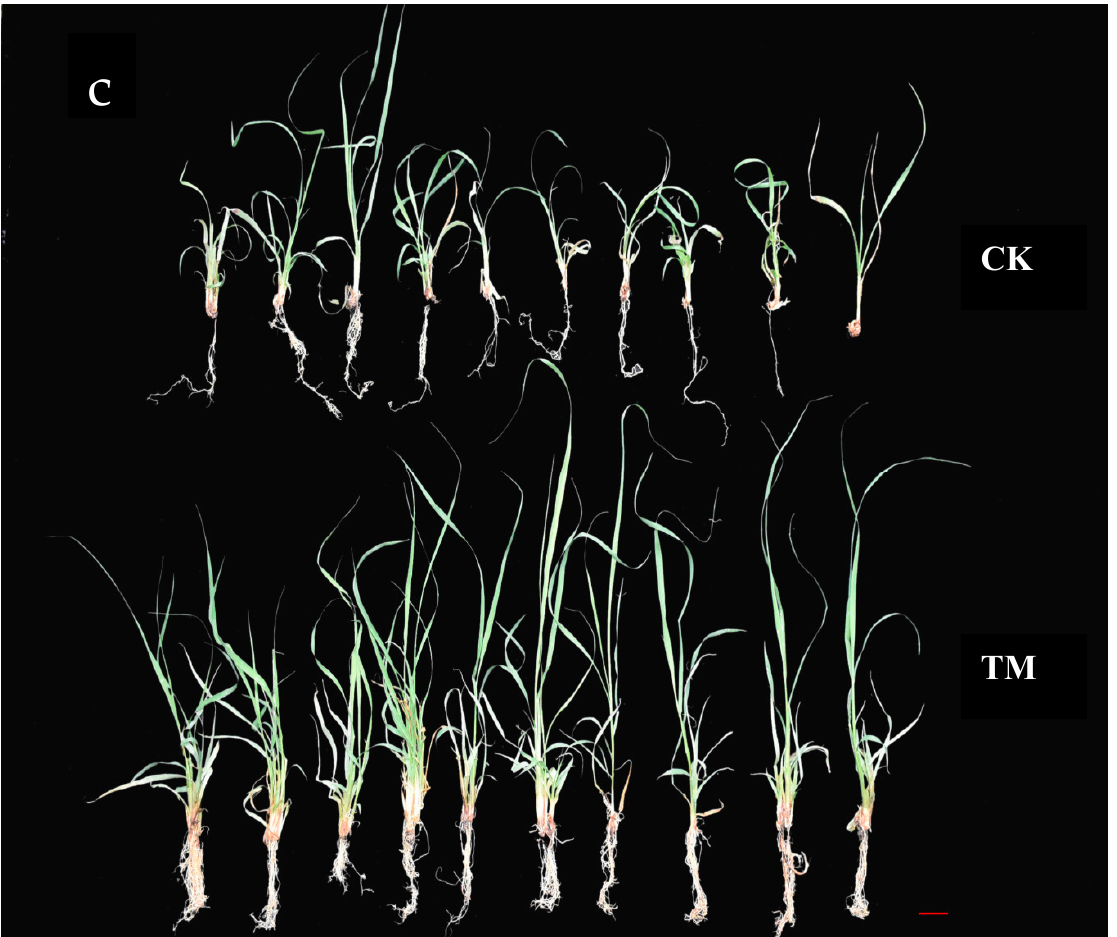
Figure 1. Effects of the indole-3-butyric acid (IBA) and 1-naphthalene acetic acid (NAA) mixture (auxin) on adventitious root (AR) formation in sugarcane. ( a ) Root number in sugarcane with auxin treatment and the control at 7, 9, 11, 13, 15, and 21 dpt (days post-treatment), *** are significantly di ff erent ( p ≤ 0.01) (Independent-Samples t -test), data was presented as mean ( ± SE). ( b ) Root length in sugarcane following auxin treatment and the control at 7, 9, 11, 13, 15, and 21 dpt, *** are significantly di ff erent ( p ≤ 0.01) (Independent-Samples t -test), data was presented as mean ( ± SE). ( c ) Morphology of microshoots treated with auxin and the control at 21 dpt. Scale bars = 0.5 cm. CK—microshoots treated with water; TM—microshoots treated with